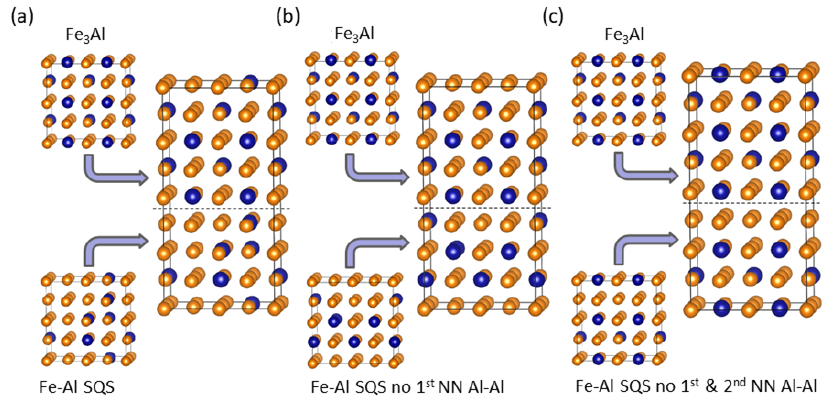
Figure 8. The same as in Figure 7 but for nanocomposite supercells with the (110) interface plane.